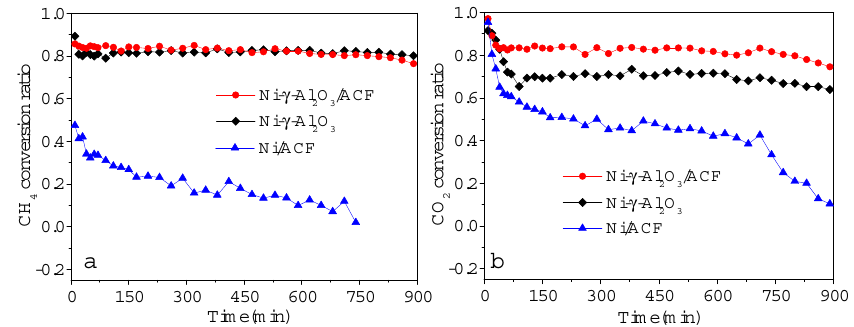
Figure 5. Catalyst stability test (a: CH 4 conversion ratio; b: CO 2 conversion ratio). Gas hourly space velocity (GHSV): 24,000 mL·h − 1 ·g − 1 ; detailed reaction conditions: CH 4 : 50 mL/min; CO 2 : 50 mL/min; N 2 : 100 mL/min; catalyst dosage: 0.5 g; temperature: 750 °C; test time: 900 min.